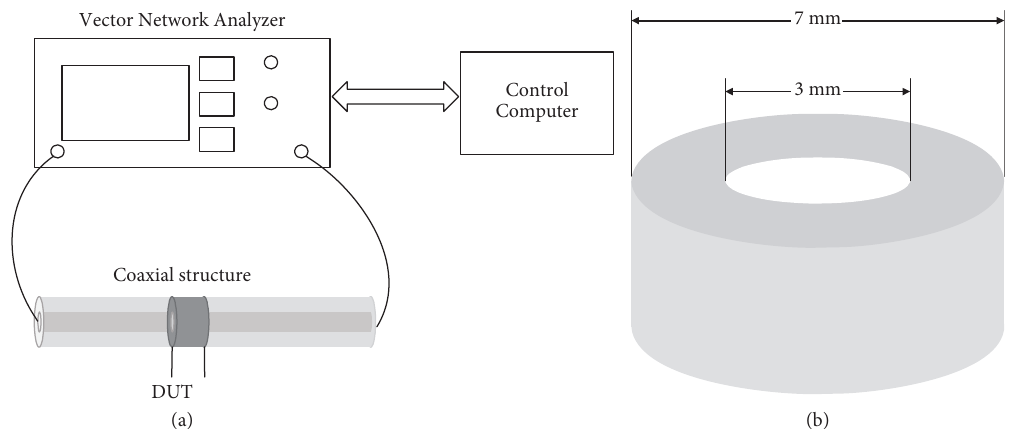
Figure 1: Schematic diagram of electromagnetic property measuring equipment and sample: (a) equipment for coaxial ring method test; (b) DUT.